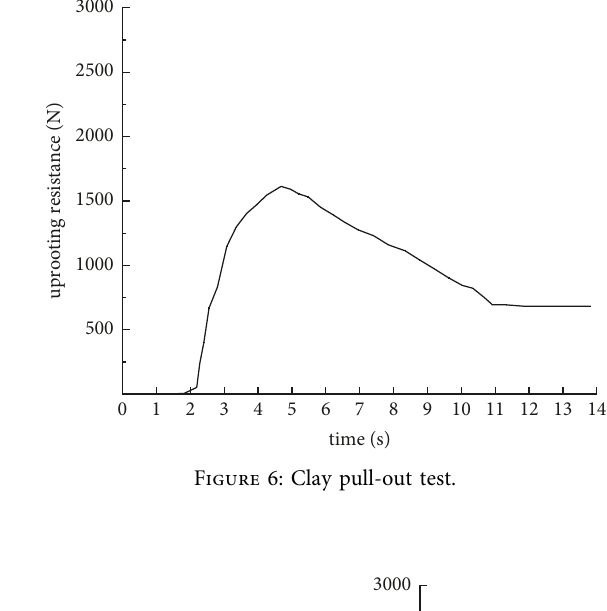
Figure 6: Clay pull-out